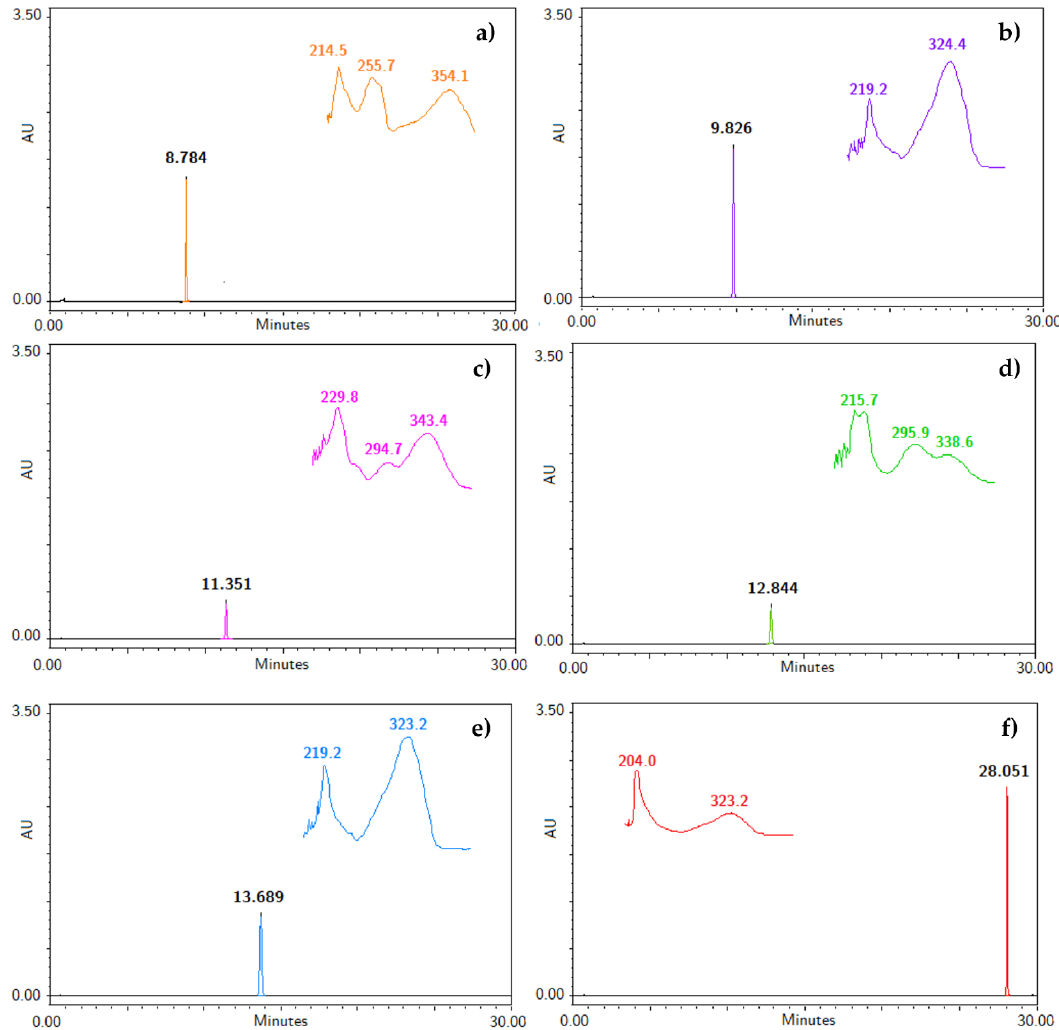
Figure 1. Chromatograms with retention time (RT) and specific UV spectra of ( a ) IS, ( b ) PE, ( c ) SC, ( d ) DF, ( e ) HR, and ( f ) PU at a concentration of 200 µg/mL. ( d ) DF, ( e ) HR, and ( f ) PU at a concentration of 200 µ